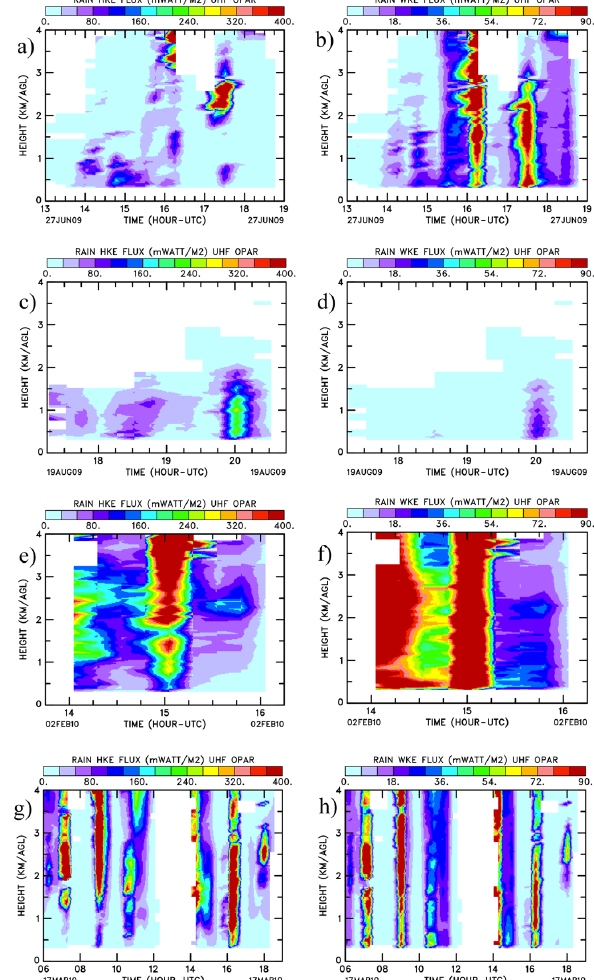
Fig. 10. Time–height sections of the rain horizontal (HKEF, left panel) and vertical (VKEF, right panel) kinetic energy flux for (a, b) 27 June 2009, (c, d) 19 August 2009, (e, f) 2 February 2010 and (g, h) 17 March 2010. A 15min average is